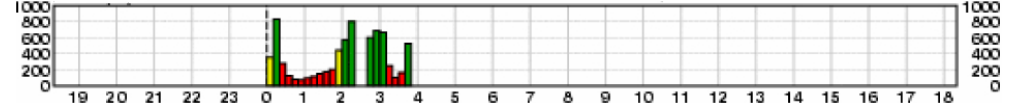
Figure 5. Synoptical visibility observations in [m] in Cabauw during 14–15 February